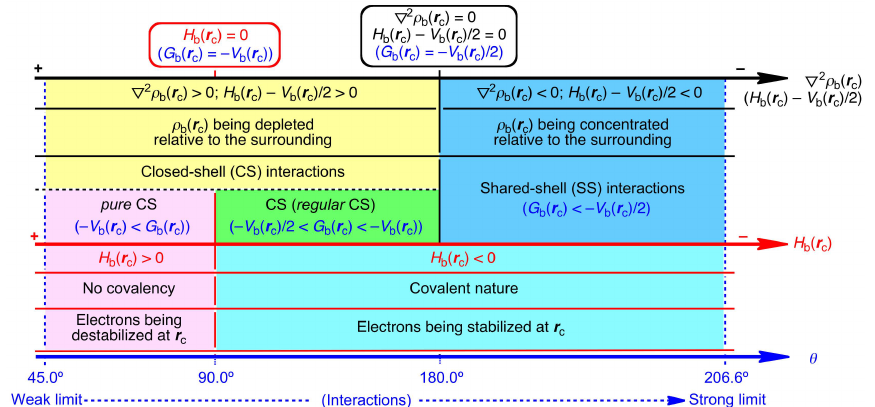
Scheme A1. Classification of interactions by the signs of ∇ 2 ρ b ( r c ) and H b ( r c ), together with G b ( r c ) and V b ( r c